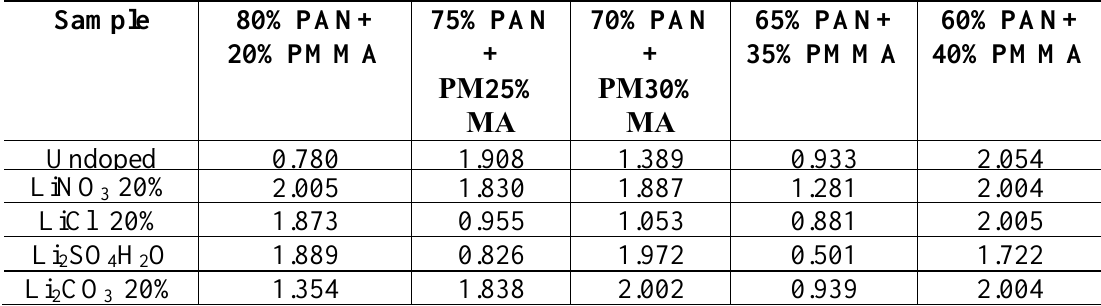
Table 2: The values of exponent (s) of undoped (PMMA+PAN) at different blends ratios and doped with various lithium